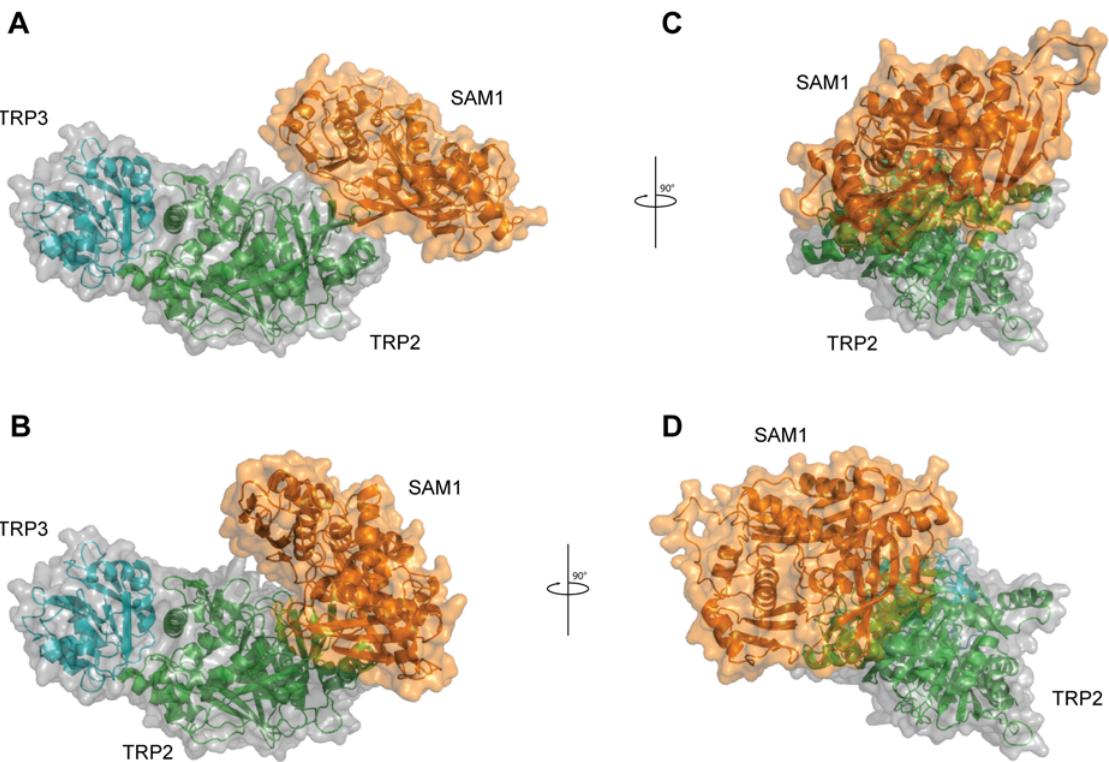
Figure 5. Completing anthranilate synthase complex (TRP2-TRP3) with SAM1. Hypothetical reconstruction of the trimeric complex between TRP2, TRP3 and SAM1. Models for TRP2 and TRP3 were superposed to the template structure of Anthramilate Synthase (PDB id 1qdl) while SAM1 was placed based on the predictions of the docking with TRP2. Two possible conformations are shown in (A,C) and (B,D). The rotation of 90 u around axis y in (C) and (D) shows the different orientation of SAM1 with respect to the rest of the complex. Figure S3 Ratio between the number of ‘‘good’’ cases (cases having at least one acceptable solution in the top n) and the total number of cases satisfying the threshold for increasing values of the threshold. (A), (C), (E) and (G) refer to ZDOCK 3.0 + pyDock while (B), (D), (F) and (H) refer to ZDOCK 3.0 alone. (A) and (B) are relative to the top 1 solution, (C) and (D) to the top 3, (E) and (F) to the top 5 and (G) and (H) to the top 10.